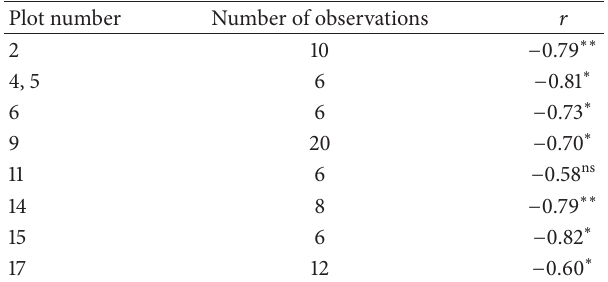
Table 6: Correlation between soil As and elevation of the plots. Plot